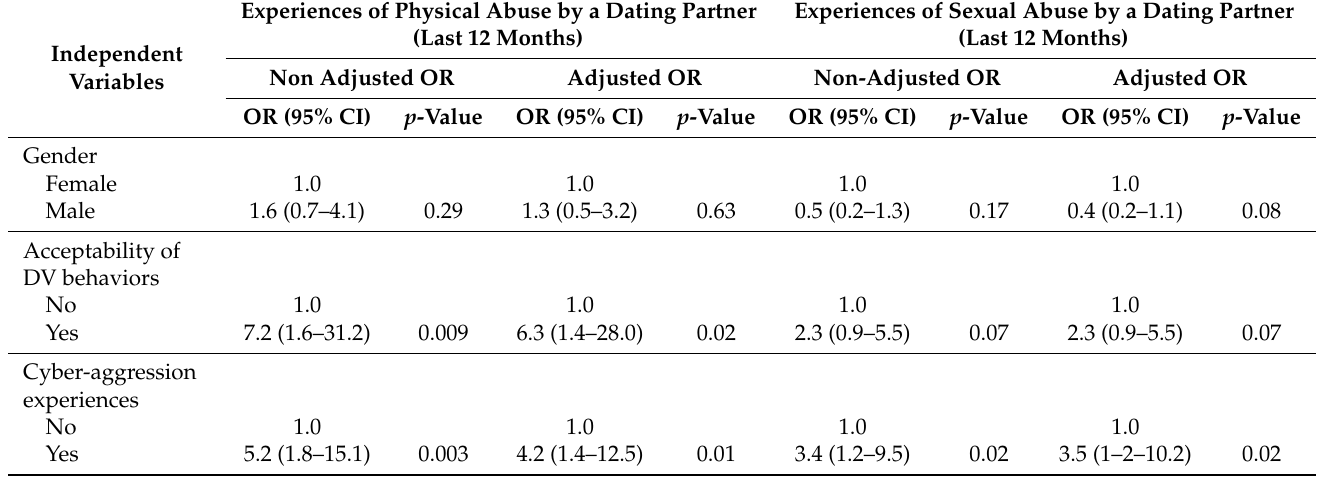
Table 5. * Univariate, multivariate logistic regression, physical, sexual abuse, acceptance of DV behaviors or experiencing cyber-aggression (n =